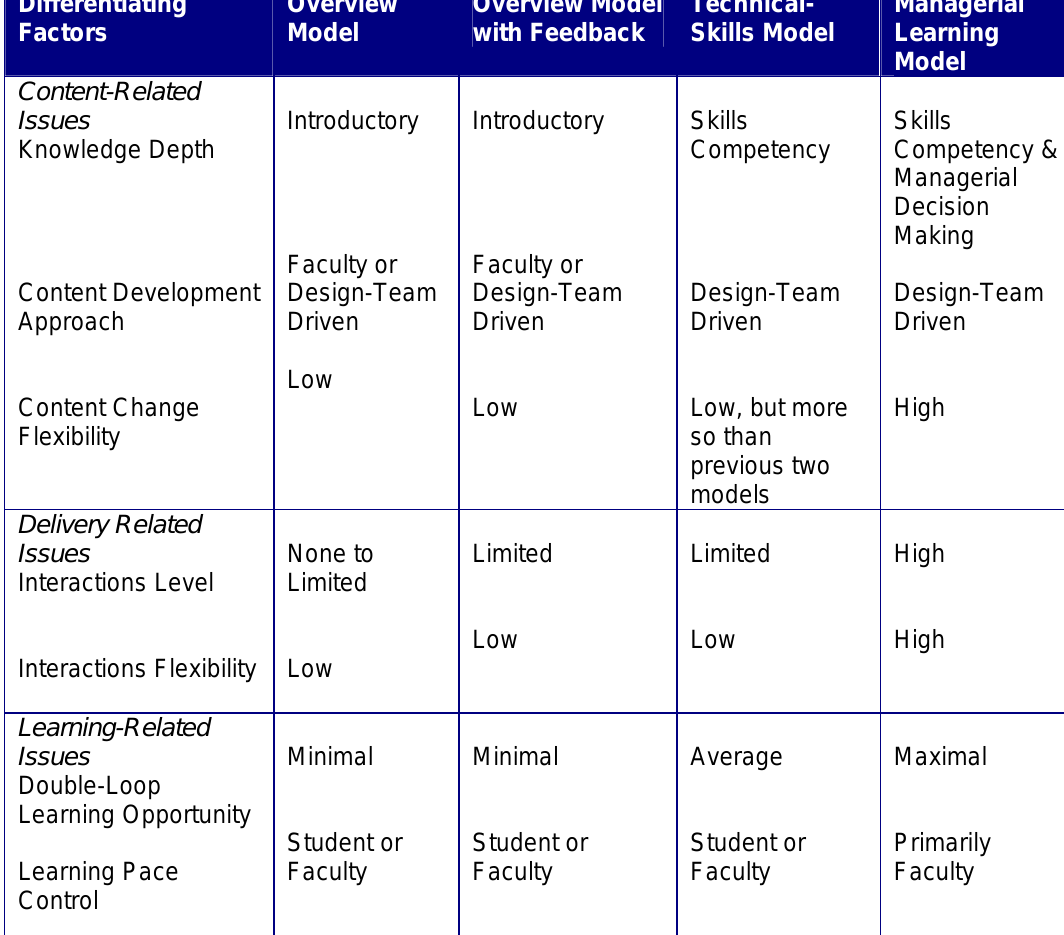
Table 1. Types of Online Distance Education